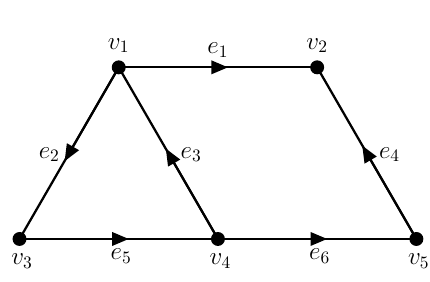
Fig. 1: A digraph used to illustrate A D , B D , and M